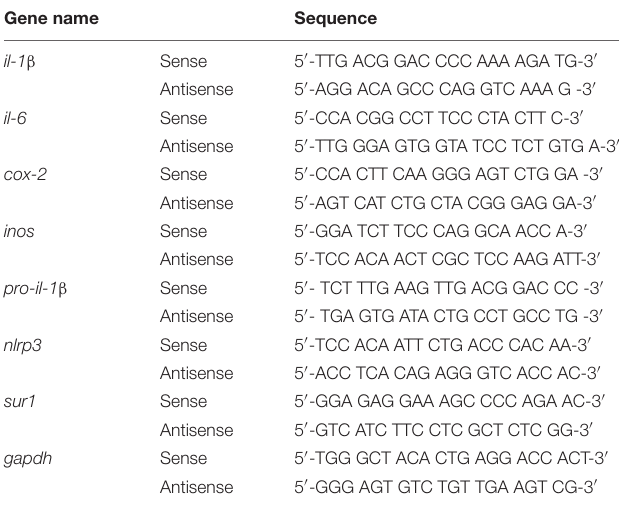
TABLE 3 | Sequences of primers used for real